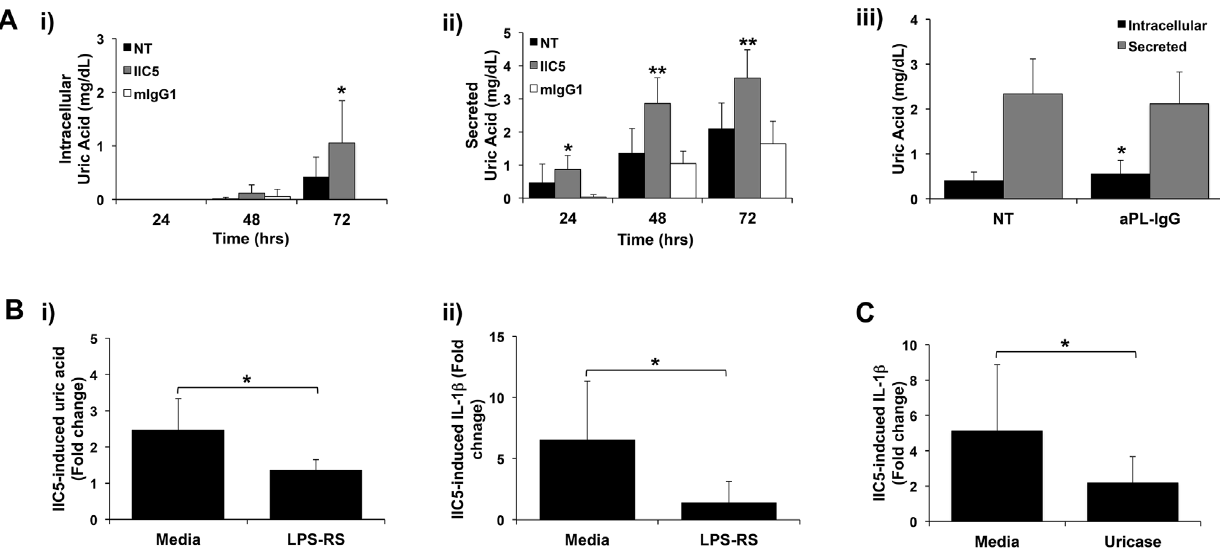
Figure 4. Antiphospholipid antibodies induce trophoblast uric acid production by trophoblasts via TLR4, which in turn triggers IL- 1 b production. (A) Trophoblast cells were either not treated (NT) or treated with (i & ii) the anti- b 2 GPI mAb, IIC5 (20 m g/ml) or mouse IgG1 control (mIgG; 20 m g/ml) for 24, 48 and 72 hrs; or (iii) aPL-IgG (500 m g/ml) for 72 hrs. Cell lysates (intracellular) and supernatants (secreted) were measured for uric acid. Data are from 4–6 independent experiments. * p , 0.05; ** p , 0.001 versus the NT control. (B) Trophoblast cells were pretreated with either media or the TLR4 antagonist, LPS-RS (10 m g/ml) for 30 mins before cells were then treated with or without the anti- b 2 GPI mAb, IIC5 (20 m g/ml) for 72 hrs. Barcharts show levels of IIC5-induced: (i) secreted uric acid and (ii) secreted IL-1 b , expressed as fold change relative to the untreated control. Data are from 4 independent experiments (* p , 0.01). (C) Trophoblast cells were treated with or without the anti- b 2 GPI mAb, IIC5 (20 m g/ml) in the presence of media or uricase for 72 hrs. Barchart shows levels of IIC5-induced IL-1 b secretion, expressed as fold change relative to the untreated